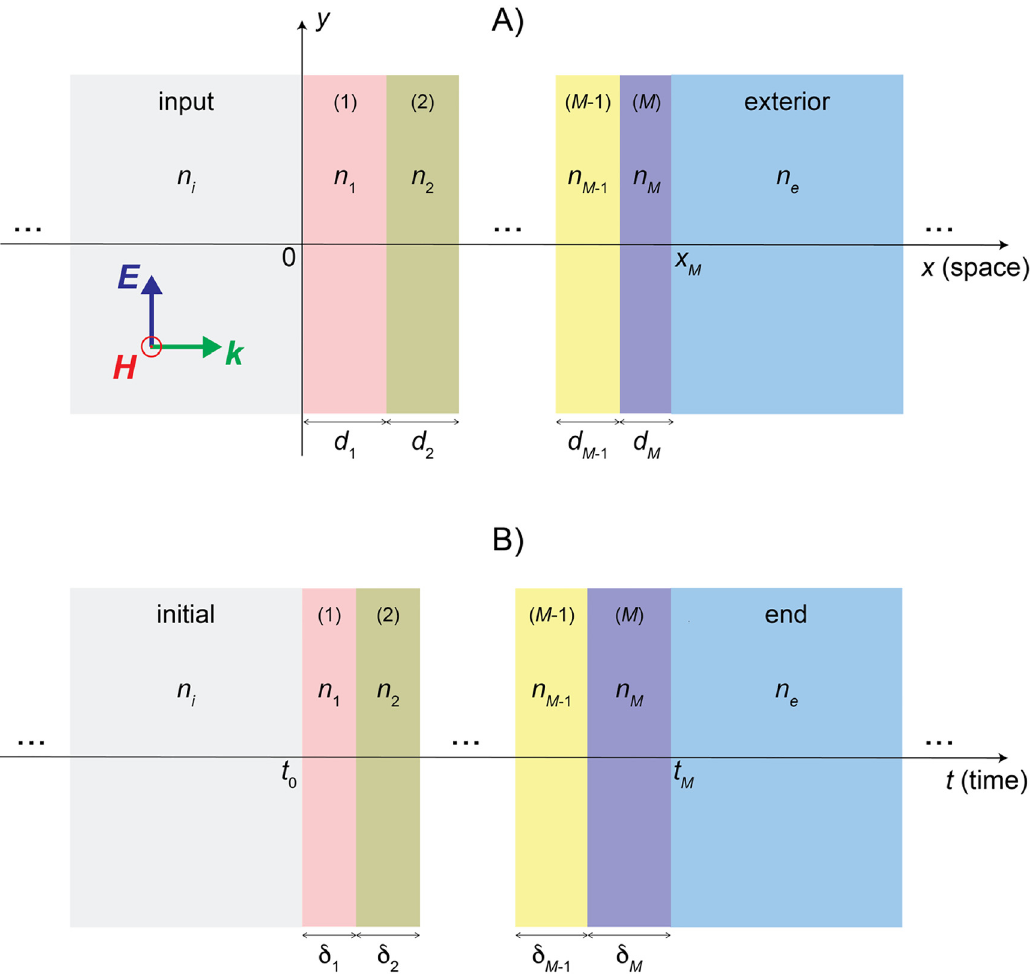
Figure 1: Problem schematic. (A) Spatial multilayer (with refractive indices n m and thicknesses d m , n = 1 , … , M ) sandwiched between two semi-in fi nite regions with refractive indices n i (input) and n e (exterior), under normally incident, plane-wave illumination. (B) Temporal transition (in a spatially unbounded medium) of the refractive index between the values n i (initial) and n e (end) via a multistep pro fi le (temporal multistep, with refractive indices n m and durations δ m , n = 1 , … , M